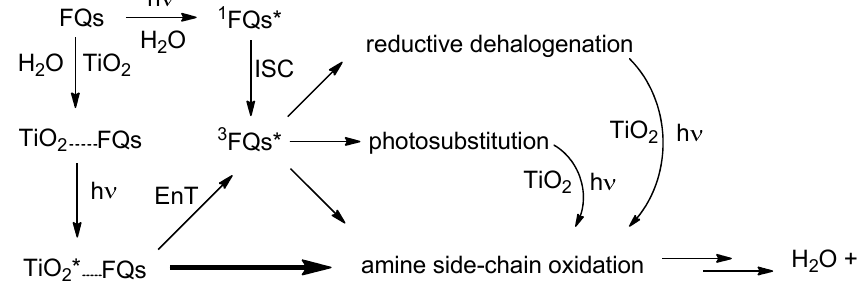
Scheme 1. Photolytic and photocatalytic degradation paths for